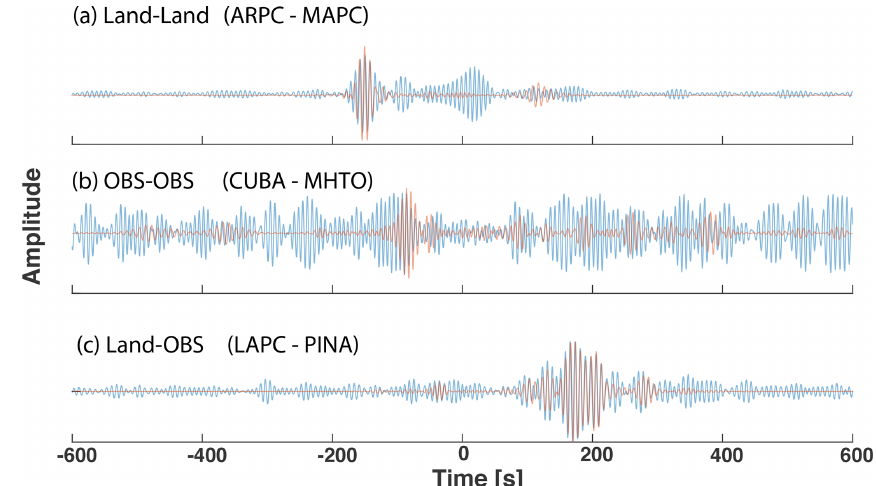
Figure 2. EGFs from three different cross-correlation pairs (EGFs) determined via linear stacking of cross-correlograms (blue) and ts-PWS stacking of the cross-correlograms (red). All EGFs are bandpass-filtered over 6–10s. This includes EGFs from (a) land stations ARPC to MAPC, (b) OBS stations CUBA to MHTO, and (c) land–OBS stations LAPC to PINA, respectively. See Fig. 1 for station locations.